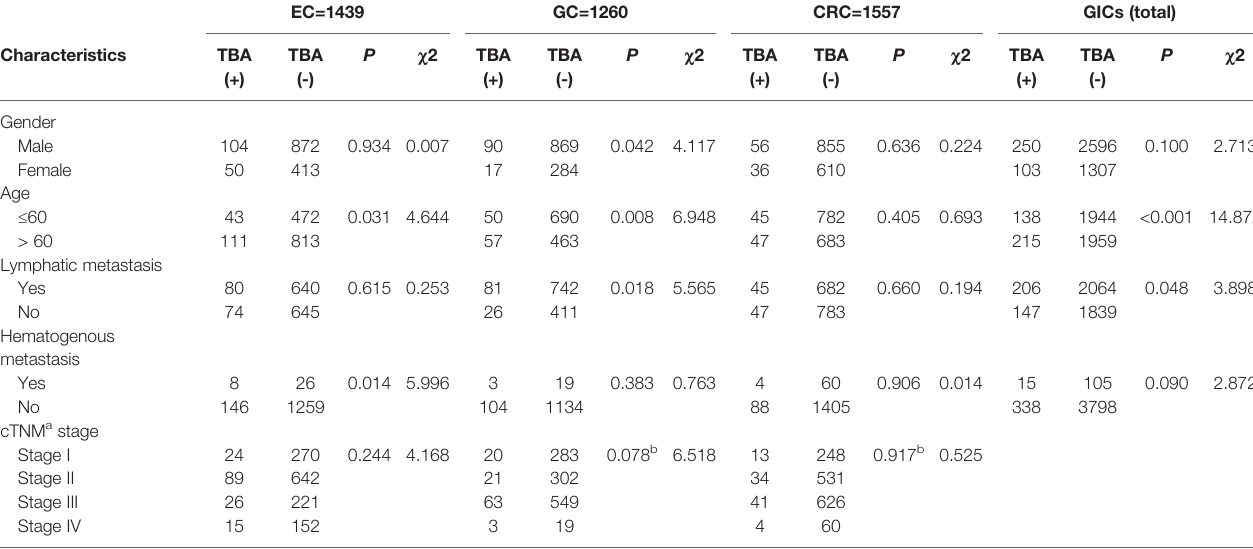
TABLE 4 | Comparison of clinicopathological characteristics between two groups strati fi ed by TBA level in the case group.